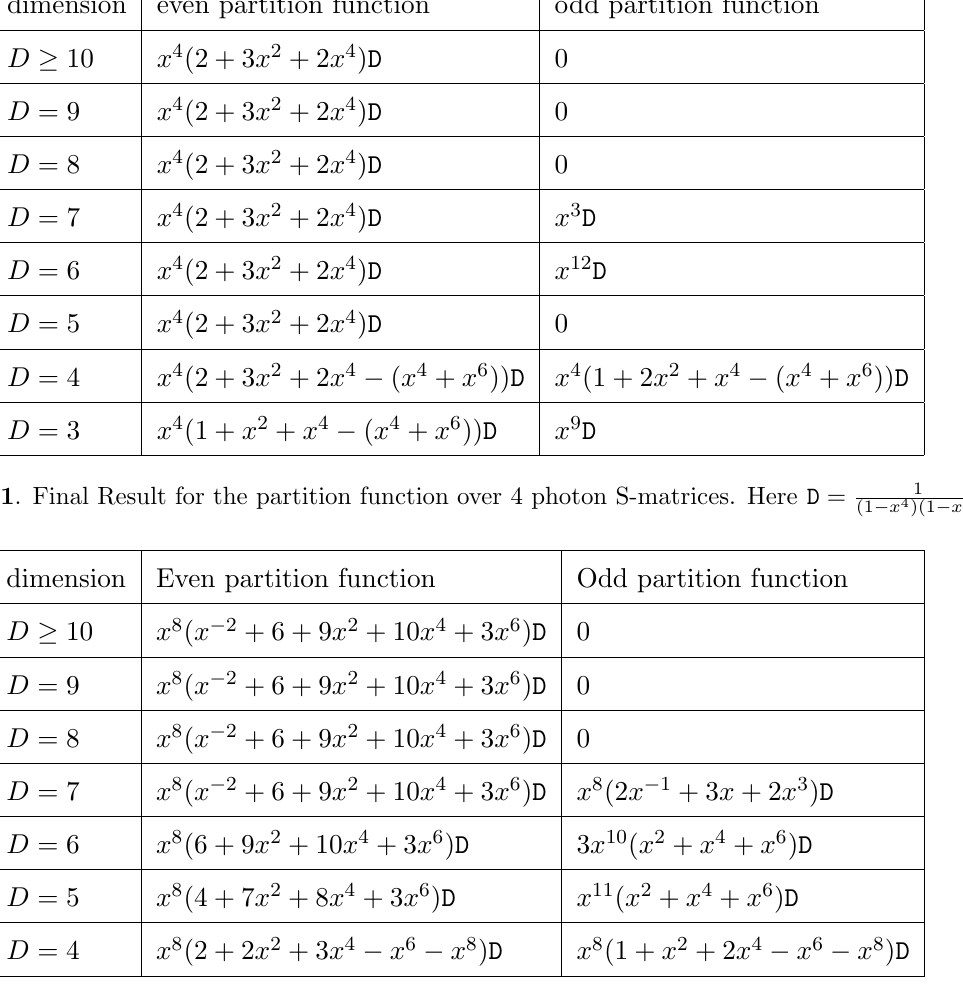
Table 2 . Final Result for the partition function over 4 graviton